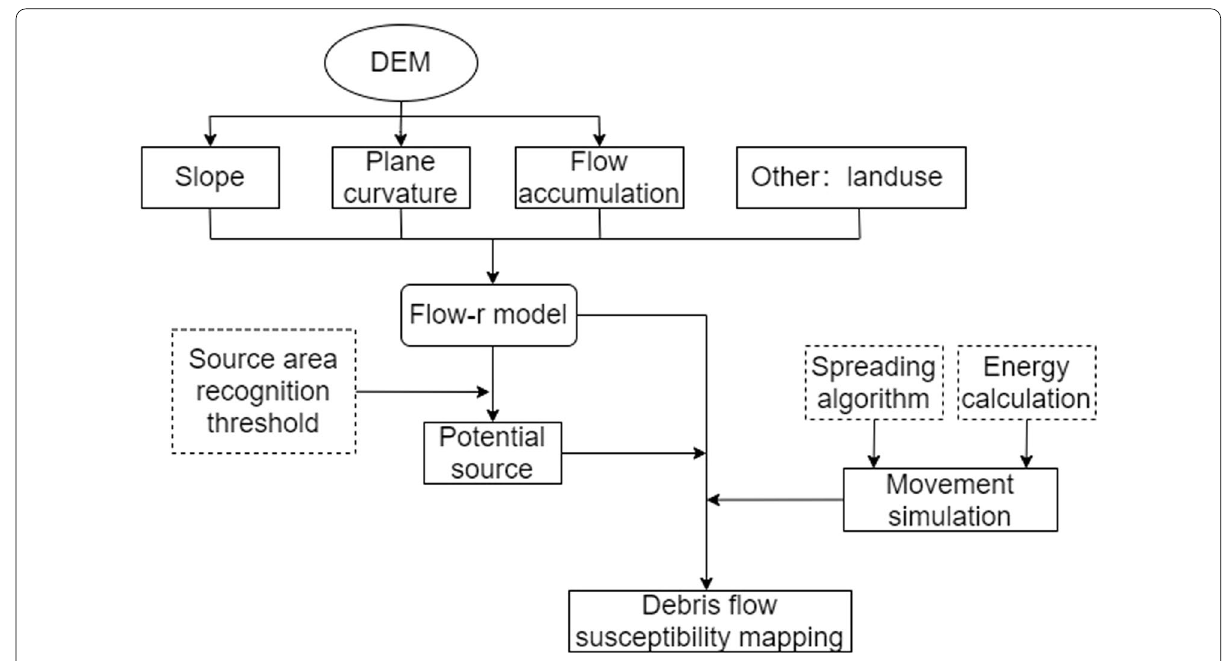
Fig. 4 Flow chart of Flow-R model